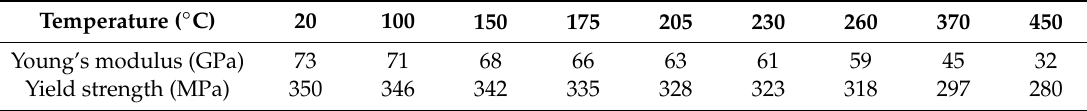
Table 3. Material properties of 2219 aluminum alloy at di ff erent temperatures.